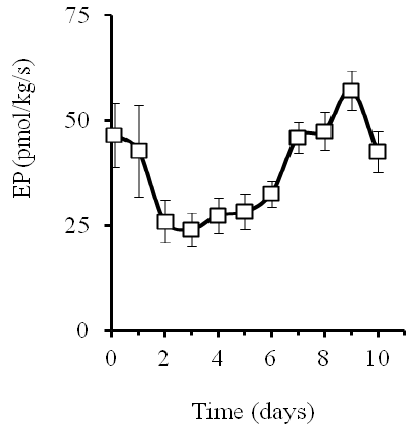
Figure 1. Ethylene production (EP) during ripening at 21 ± 1 °C and 93% ± 3%